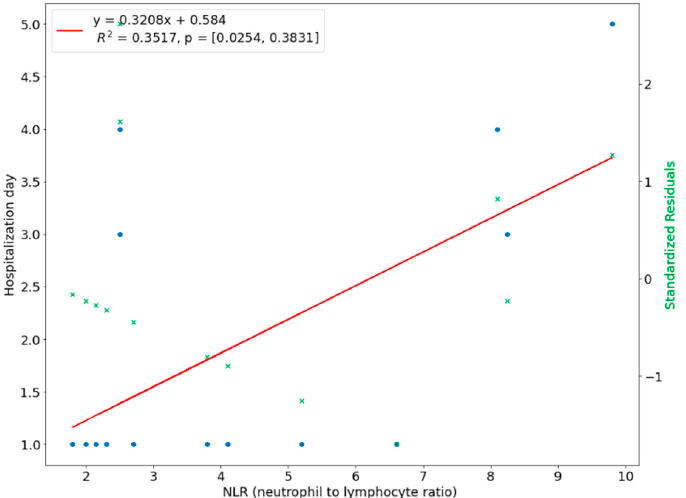
Figure 9. Correlation of CRP with length of hospital stay in upper face odontogenic infections.